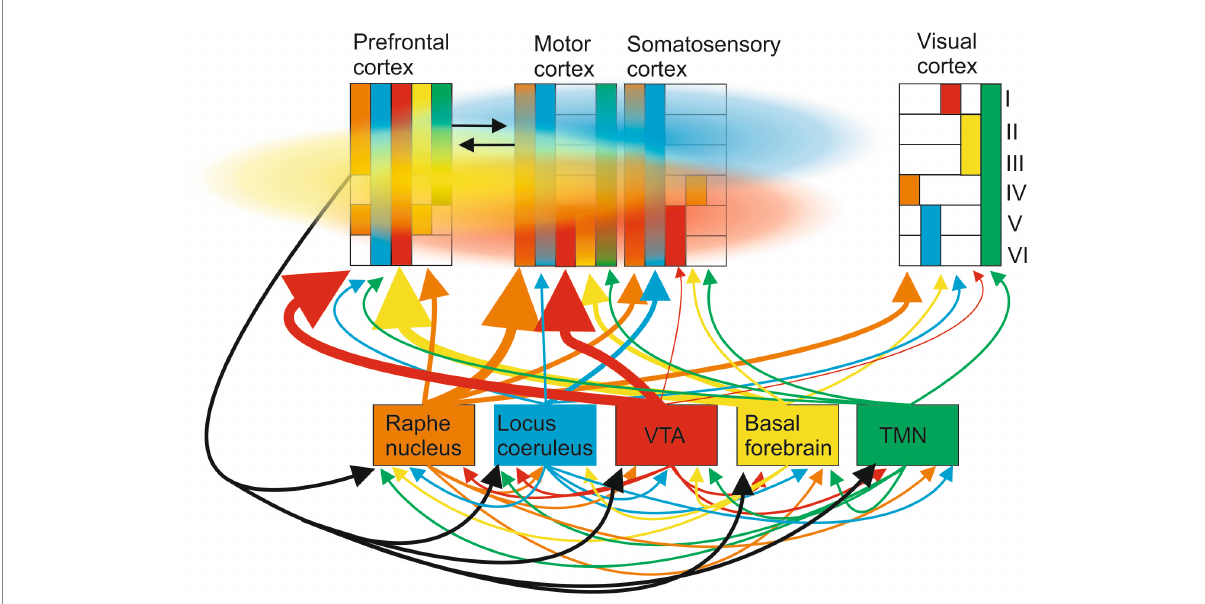
FIGURE 4 Ascending modulatory pathways make wired connections to multiple cortical areas (regional projections to different cortical areas and layers are indicated by the size of the ascending arrow and the colored blocks in the different cortical regions; layers are indicated by the roman numeral on the right). These include cholinergic inputs from the basal forebrain, noradrenergic inputs from the locus coeruleus, serotonergic inputs from the raphe nuclei, dopaminergic inputs from the substantia nigra and ventral tegmental area, and histaminergic inputs from the hypothalamus. These systems also connect directly to each other and receive cortical feedback. Cortical signaling occurs through wired axonal connections (black arrows) and volume transmission (colored clouds), the direction and extent of volume signals reflecting ease of diffusion in different